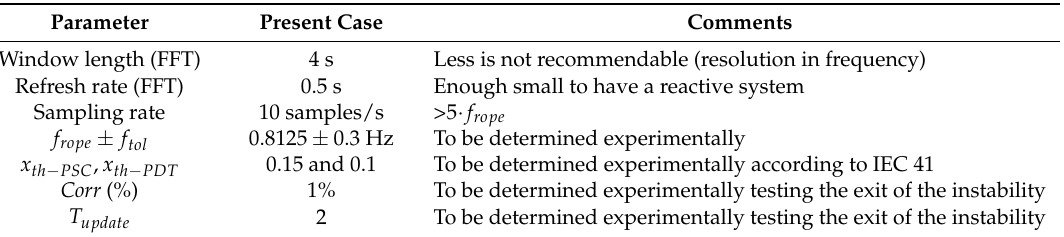
Table 3. Configuration parameters for the protecting